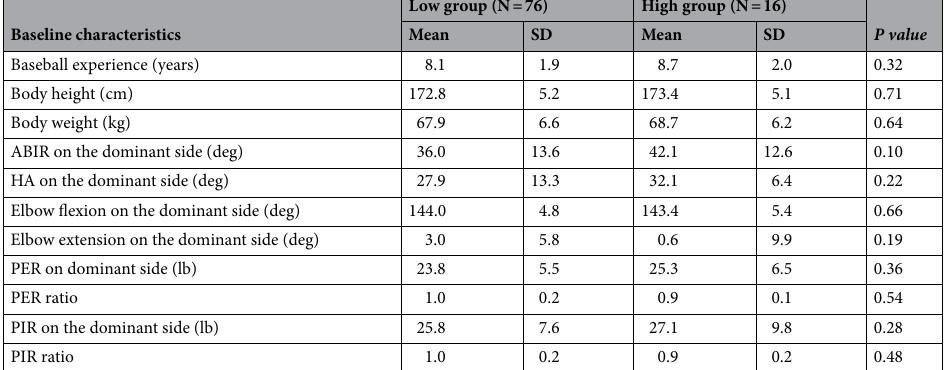
Table 1. Baseline characteristics of the study participants. ABIR ROM of 90° of abducted internal rotation in the shoulder, HA ROM of horizontal adduction in the shoulder, PER prone external rotation, PIR prone internal rotation, ratio strength of the dominant side/strength of the nondominant side, SD standard deviation, ABIR abducted internal rotation, HA horizontal adduction, ROM range of motion.